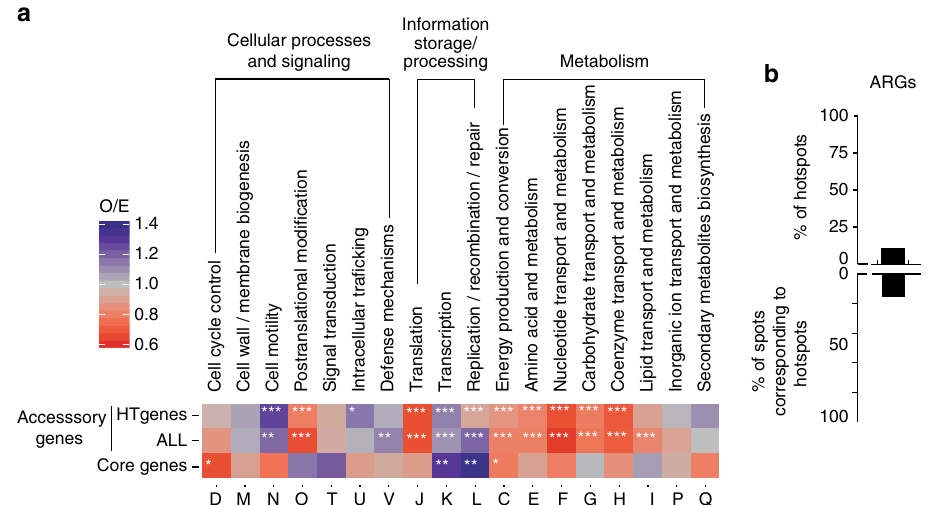
Fig. 4 Functional characterization of hotspots. a Observed/expected (O/E) ratios of non-supervised orthologous groups (NOGs, shown as capitalized letters ). The fi rst two lines represent the values of HTgenes and accessory genes observed in hotspots when the null model was computed from the distribution of the same type of genes in coldspots. The last line shows the same type of analysis for the core genes fl anking hotspots when the null model is computed using the core genes not fl anking hotspots. Expected values were obtained by multiplying the number of HTgenes, accessory, or core genes in hotspots by the fraction of genes assigned to each NOG. * P < 0.05; ** P < 10 − 2 ; *** P < 10 − 3 , χ 2 -test. b Percentage of hotspots with antibiotic resistance genes (ARGs, top ), and percentage of spots with ARGs that are hotspots ( bottom ). Note that hotspots are only 1.2% of all the spots